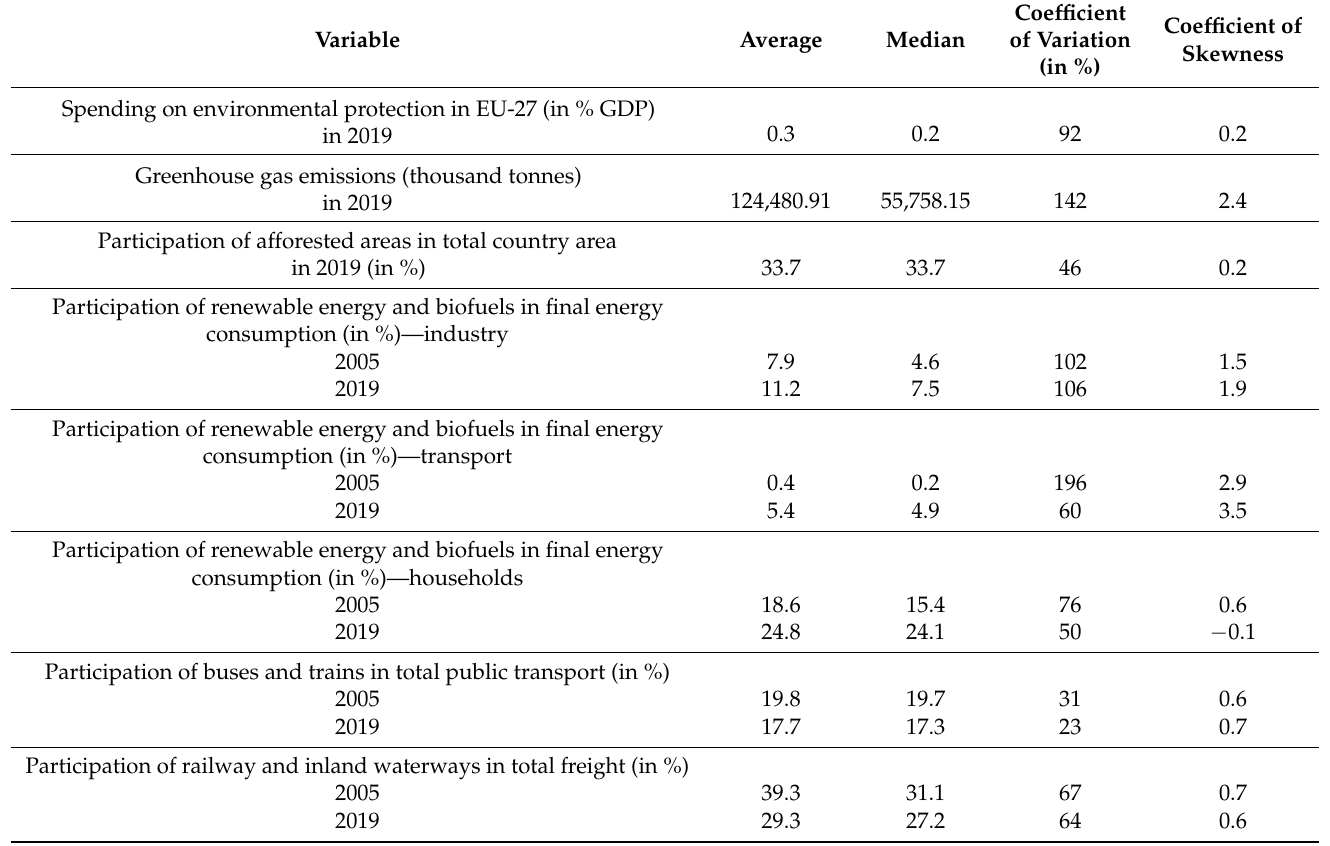
Table A1. Basic statistics of variables used in DEA method and soft